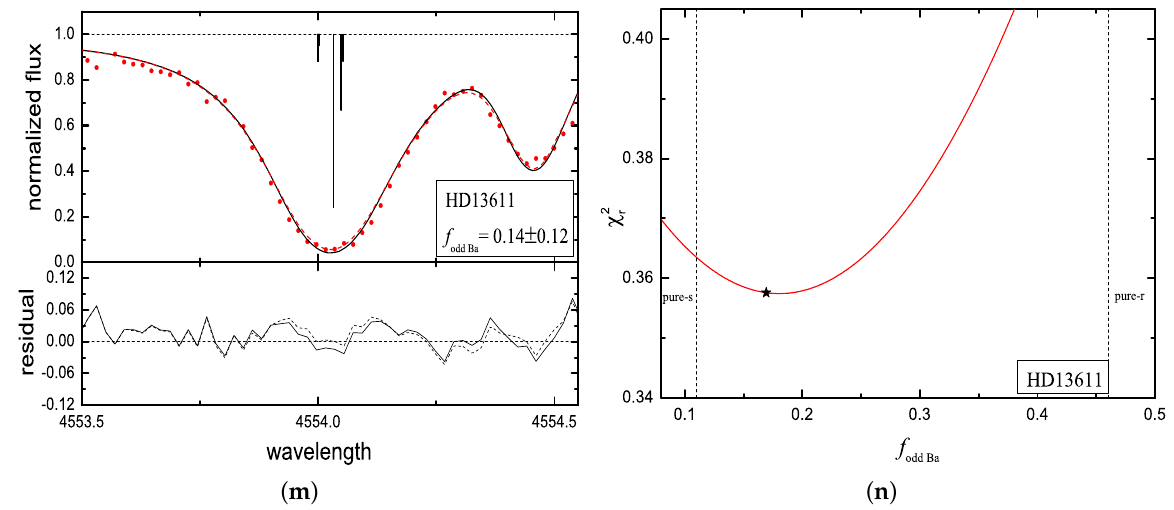
Figure 4. Left panel ( from top to bottom ): The best statistical fits of the synthetic profile to the observed (filled circles) BaII resonance lines at 4554Å for our sample Ba stars are shown in the sub-figure above, respectively. The residual plots of each sub-figure are shown below, respectively. The synthetic lines with f odd,Ba − δ and the corresponding residuals are plotted (dotted lines) in each of the sub-figures for comparison. Right panel ( from top to bottom ): We show the χ 2 fit for the λ 4554 line, and every black asterisk shows where the minimum of the fit lies. The vertical dotted lines indicate the f odd,Ba of the solar pure s-process ( left ) and pure r-process ( right ), respectively.